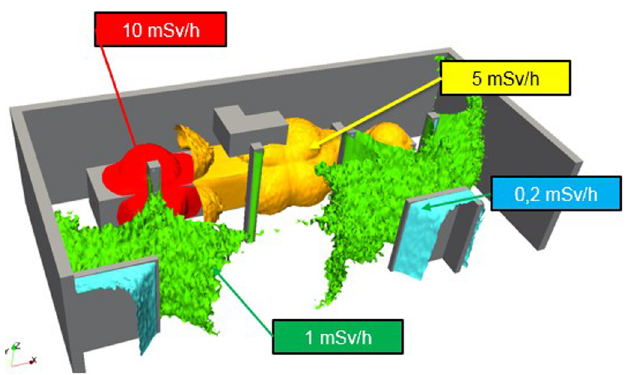
Fig. 6. Filtering units iso-surface dose